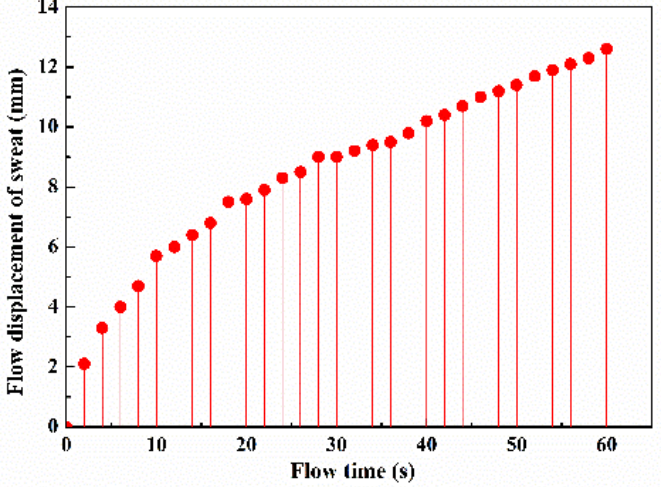
Figure 8. Record of sweat flow displacement in a paper-based wax channel with a width of 1.2 mm.